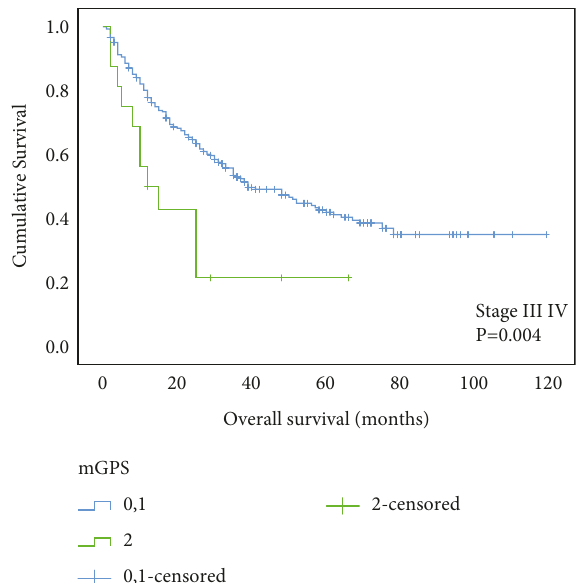
Figure 3: Relationship between the mGPS and overall survival in patients with stage III and IV gastric